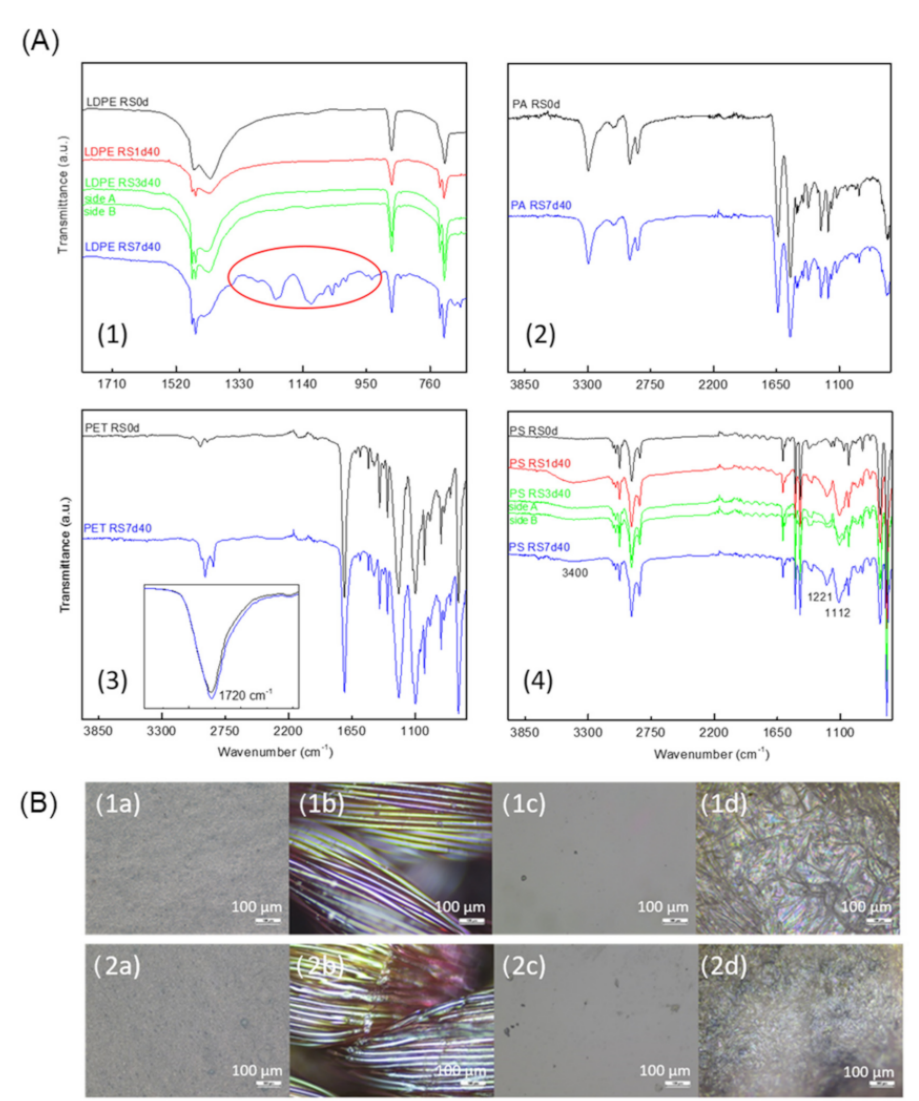
Figure 4. ( A ) FTIR spectra of RS samples of LDPE (1), PA (2), PET (3) and PS (4) at different test times in enzymatic detergent at 40 ◦ C and ( B ) Optical microscopy images of RS samples (LDPE (a), PA (b), PET (c) and PS (d)), before the test (1) and after one week in in the enzymatic detergent (2). Samples are identified as RSXdY, where X and Y indicate the number of days and the treatment temperature, respectively, and the red circle indicates a spectral region of interest mentioned in the